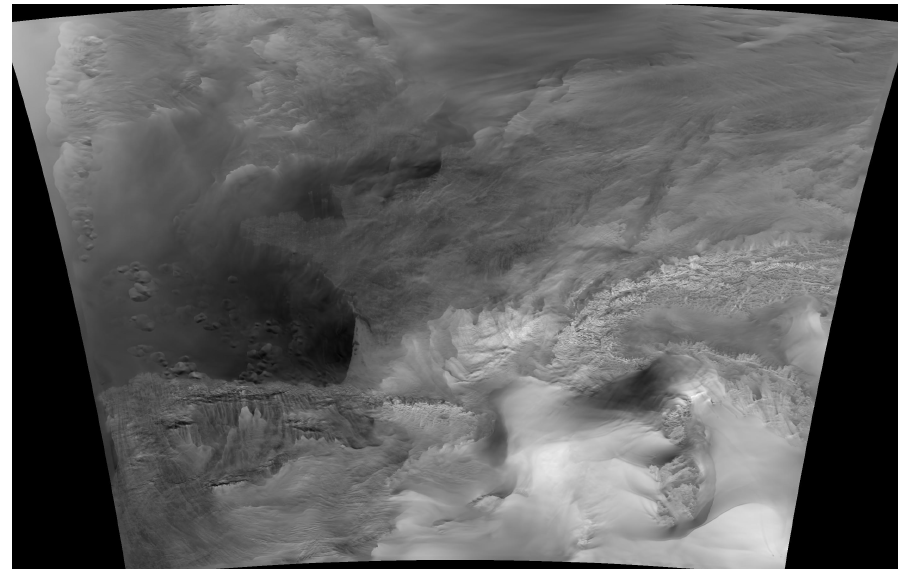
Figure 5. Wind v -component (0.01 deg